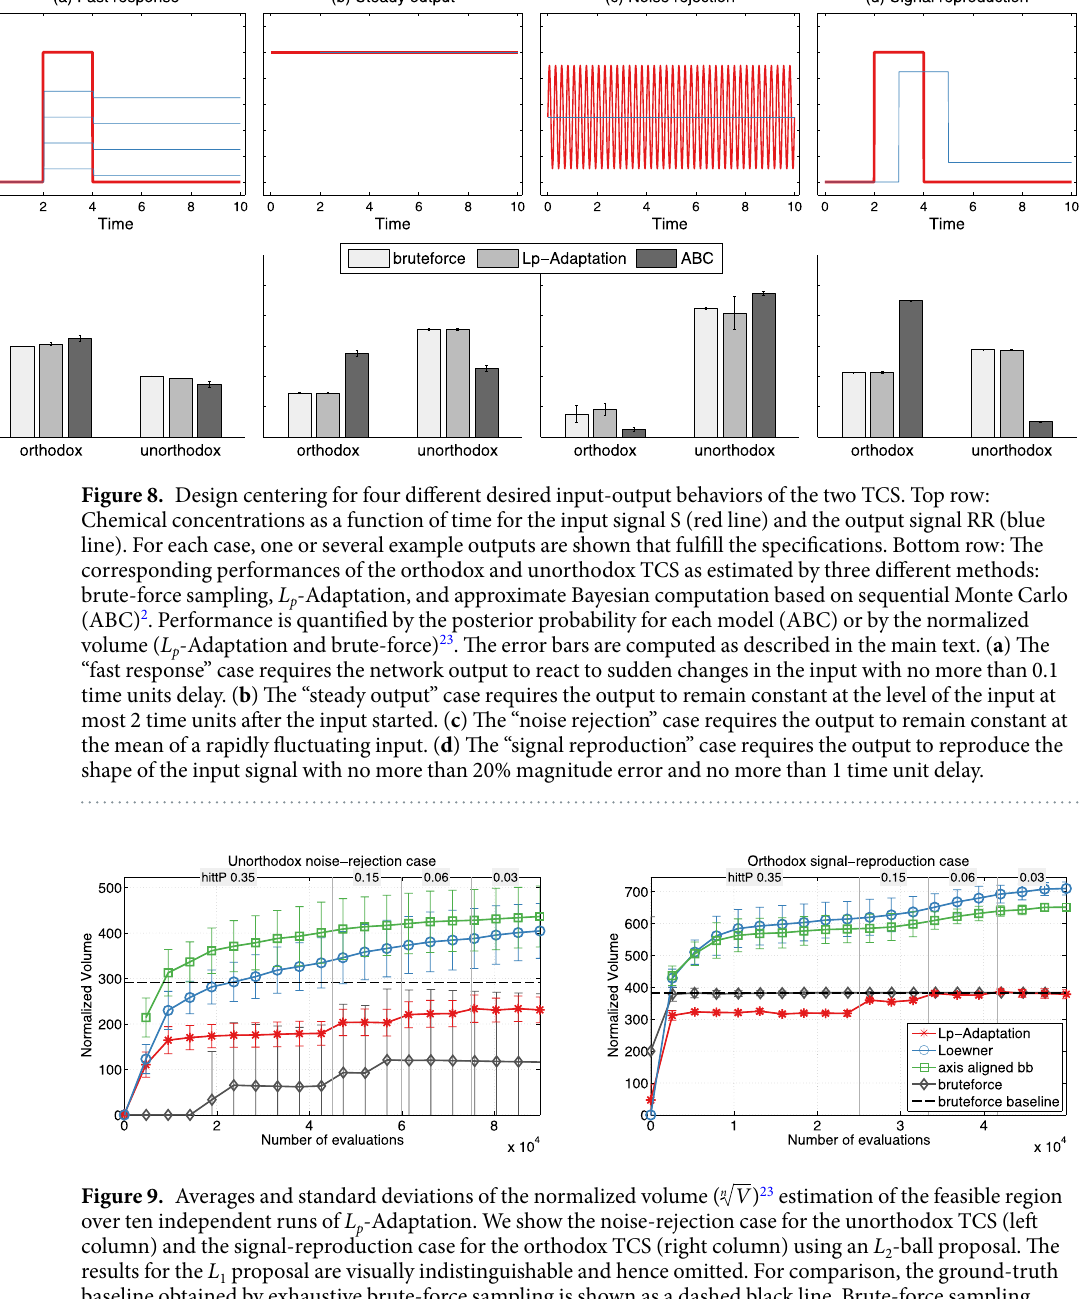
deviation across ten runs, each with a sample size of 5 ⋅ 10 4 for the orthodox and 9 ⋅ 10 4 for the unorthodox system. The error bars for ABC show the variability in the marginal model posteriors over three runs 2 . The “fast response” case requires the network to rapidly react to abrupt changes in the input stimulus S (Fig. 8(a)). Here, all three approaches reach the same conclusion: both systems are able to achieve the desired input-output response, but the orthodox system outperforms the unorthodox system. Faithfully reproducing a constant input stimulus is the goal of the “steady output” case (Fig. 8(b)). Here, L p -Adaptation agrees with brute-force sampling that the unorthodox system can more robustly produce this behavior, whereas ABC prefers the orthodox system. The “noise rejection” case aims to design a network that reproduces a constant signal while rejecting high-frequency fluctuations about it (Fig. 8(c)). This is much more robustly realized in the unortho- dox system, as agreed by all three methods. Finally, the “signal reproduction” case is to design a TCS network